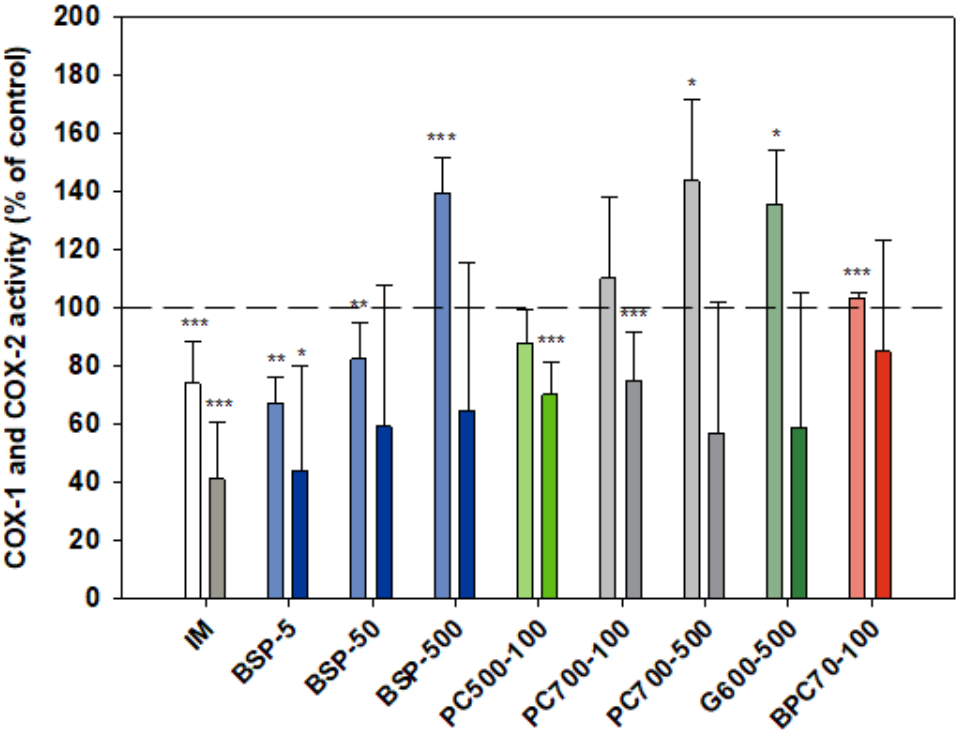
Figure 5. Cox-1 (lighter bars) and Cox 2 (darker bars) responses presented relative to control. Values are means and SD (represented by error bars). Cox-2 response is in the presence of LPS. Different bar colours refer to different ingredients as indicated on the bottom axis (as described in Methods section and Table 1), with the last set of digits on each label indicating the ingredient dose (μg/mL). The positive control is indomethacin (IM, 1 mM final concentration). Values represent either the means from one experiment with triplicate measurement, or the pooled means from 2–4 independent experiments with triplicate measurement. Data for indomethacin represents the mean from 3 independent experiments with triplicate measurement. Significance relative to control, * p < 0.05; ** p ≤ 0.01; *** p ≤ 0.001.